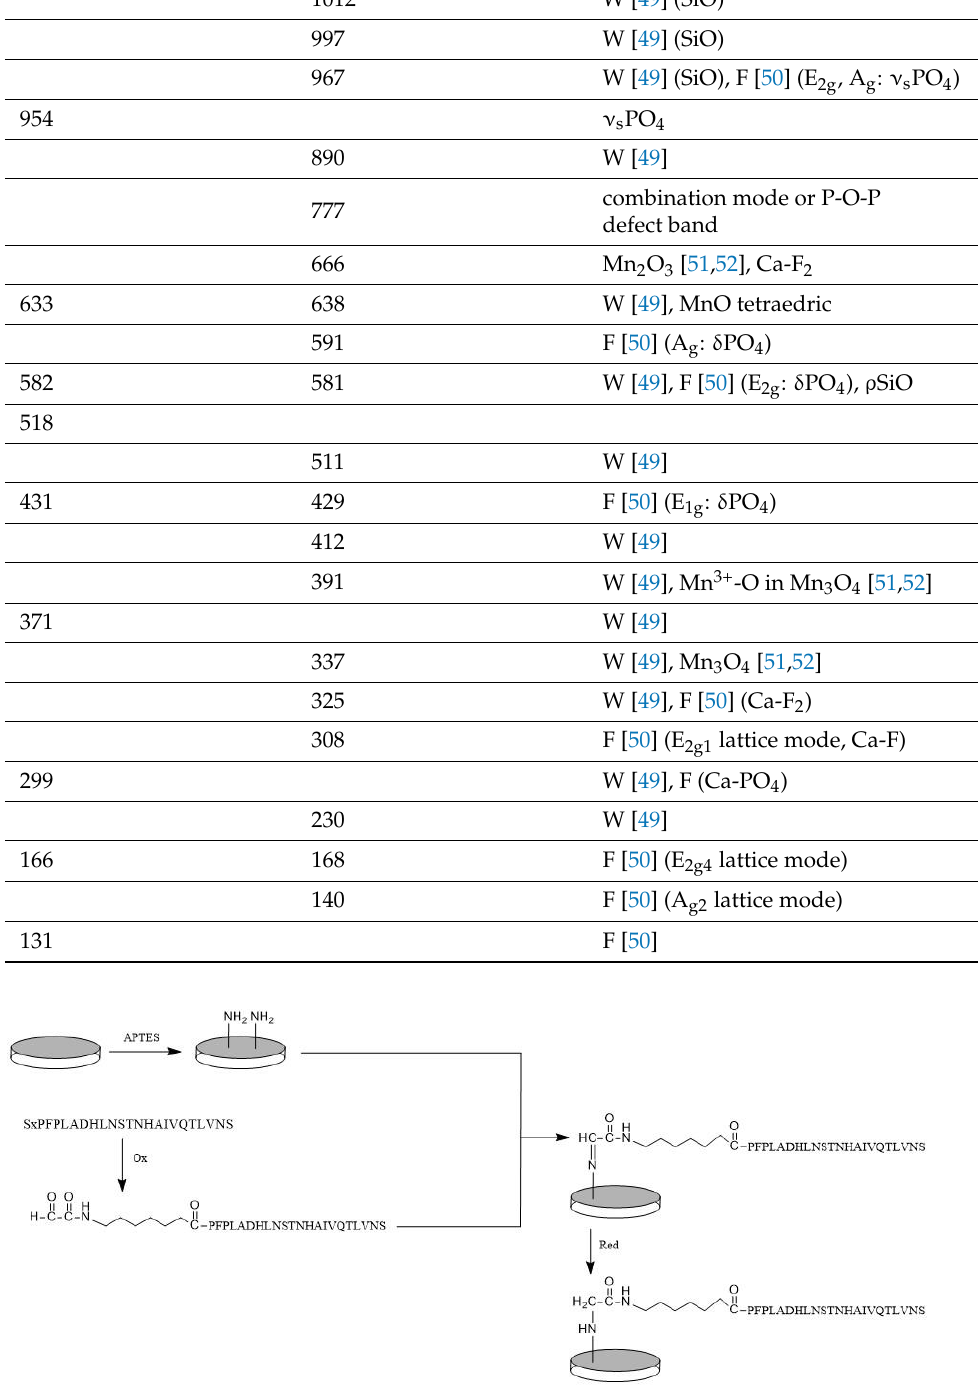
Scheme 1. Peptide anchoring strategy.